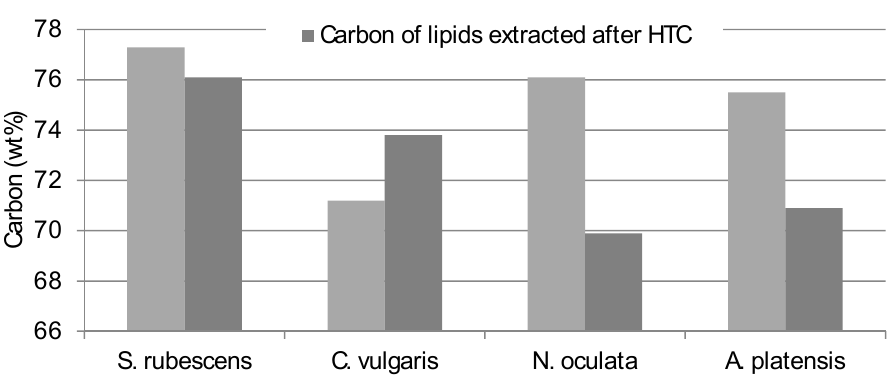
Figure 2. Carbon content of direct and after HTC extracted lipids.